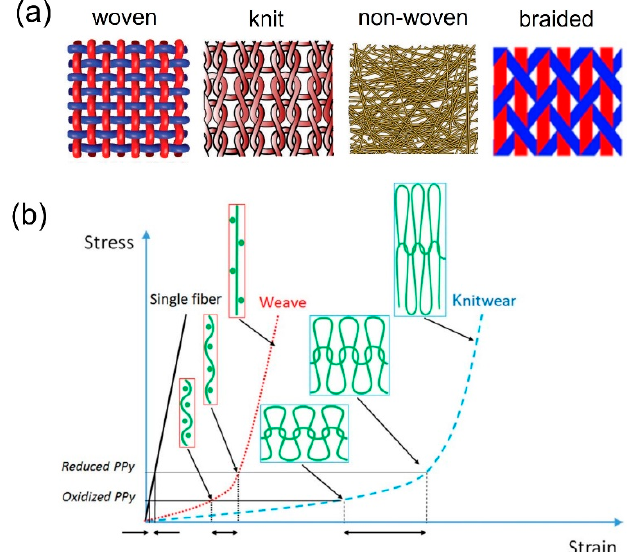
Figure 10. ( a ) Illustration of different fabric patterns; Reprinted with permission from Refs. [7,89]. 2020, Wiley-WCH; 2013, Elsevier, and ( b ) stress–strain characteristics of the fabric materials, including single fiber, woven fabric, and knit fabric. Reprinted with permission from Ref. [88]. 2015, American Association for the Advancement of Science.